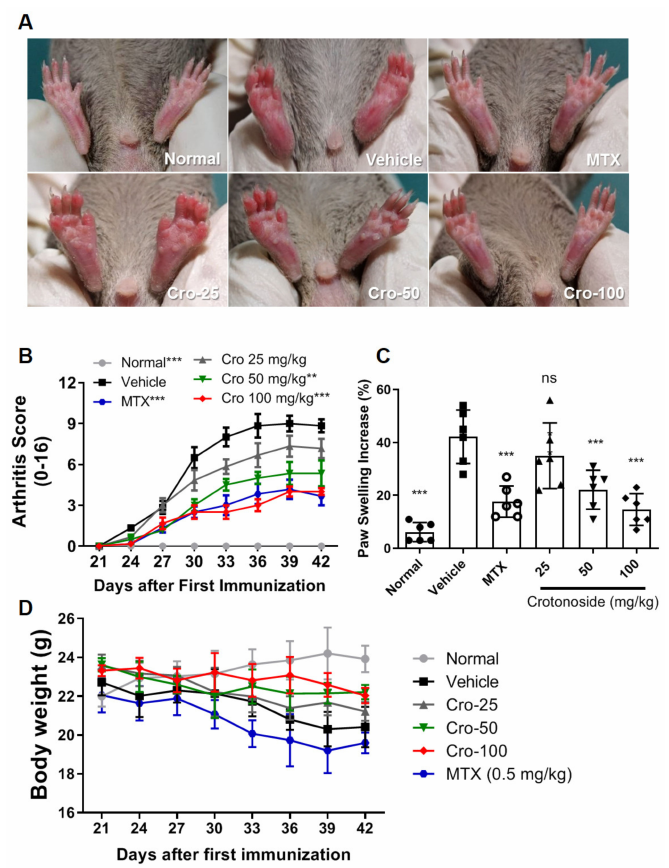
Figure 1. Crotonoside ameliorated the severity of collagen-induced arthritis (CIA) in mice. ( A ) Representative photographs of the hind paws of CIA mice on day 42. ( B ) Arthritis scores were monitored every 3 days after immunization booster. ( C ) Paw swelling levels were measured through the volumes of the hind paws using a paw volume plethysmometer. ( D ) Body weights of normal, vehicle-treated CIA, and CIA mice treated with methotrexate (MTX, 0.5 mg / kg) or crotonoside (25, 50, or 100 mg / kg); Data are representative of three independent experiments, and values are expressed as mean ± SD ( n = 6 per group). ** p < 0.01 and *** p < 0.001 versus vehicle-treated CIA control mice calculated with two-way